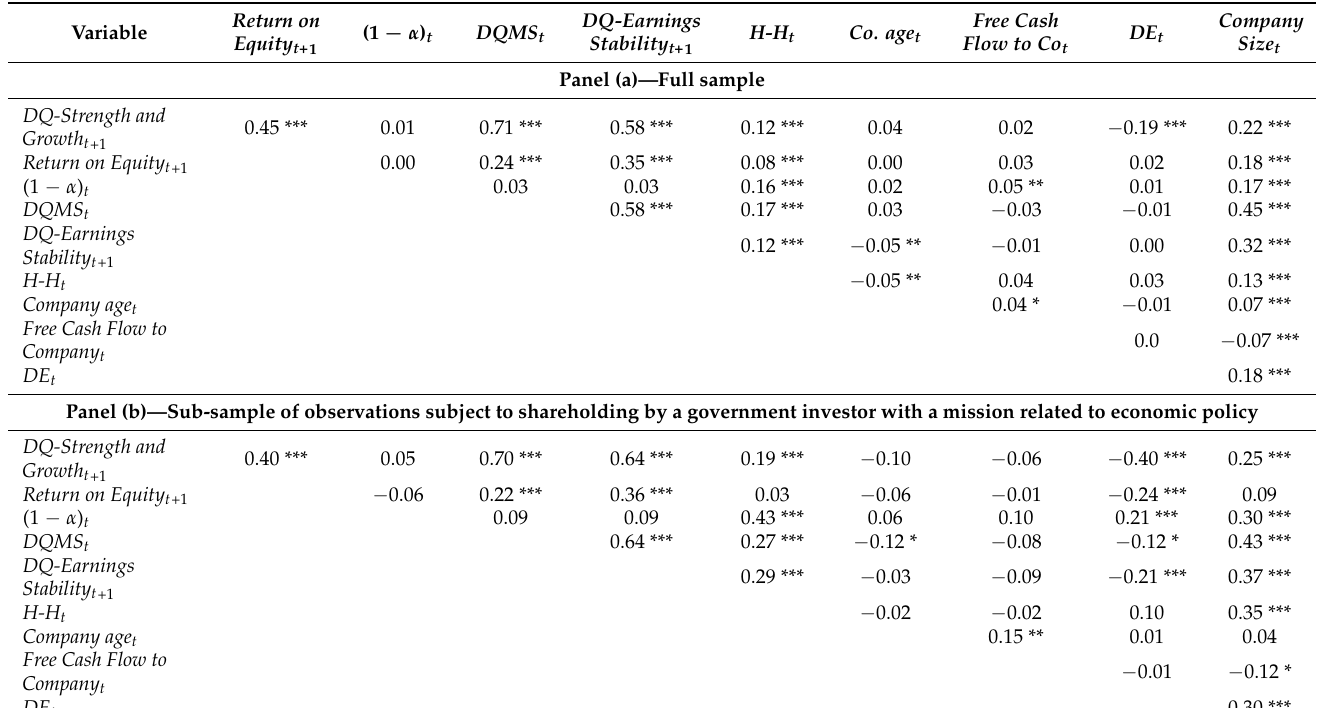
Table 3. Bivariate Pearson correlations between pairs of continuous